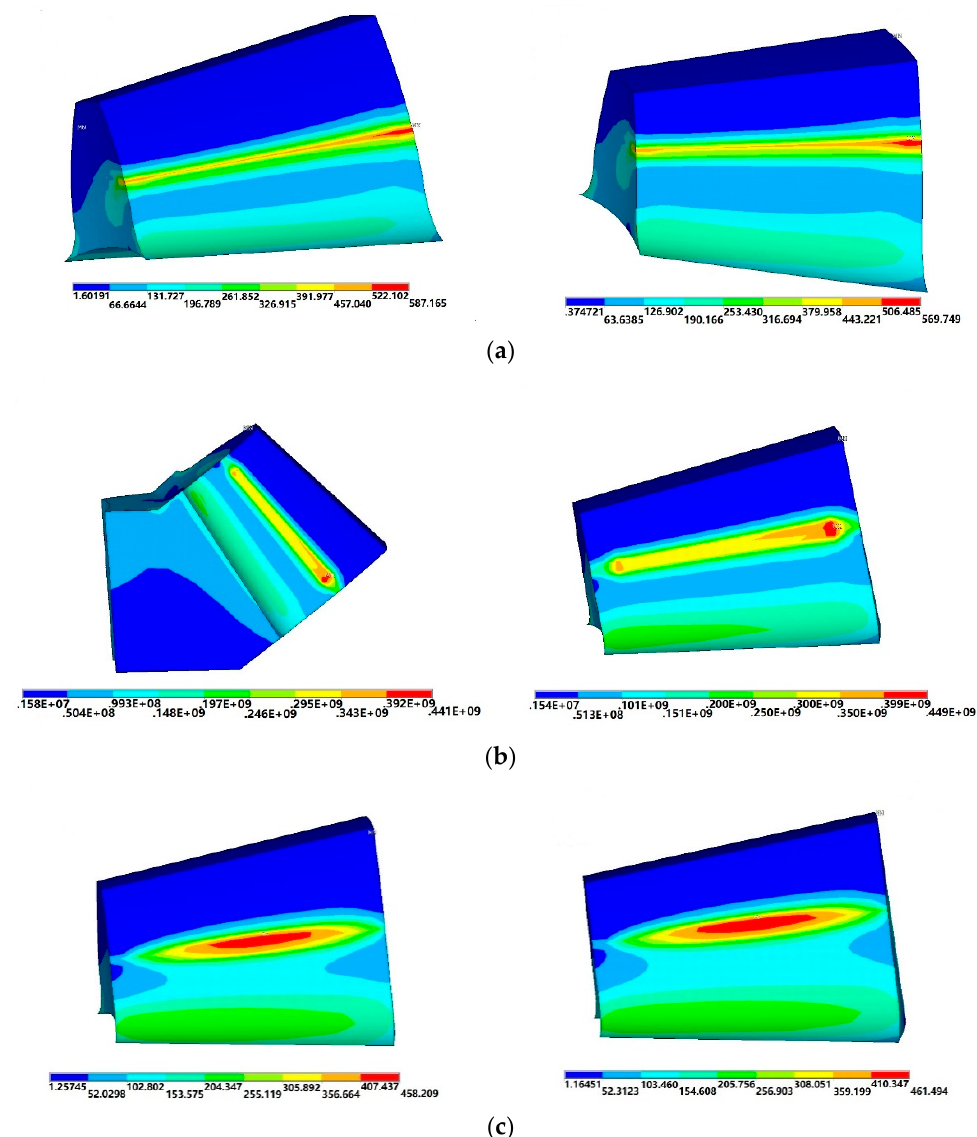
Figure 10. Distribution of contact stress on tooth surface for pinion (left) and the gear (right) in standard installment. ( a ) No modification, ( b ) Case4 and ( c ) Case1.